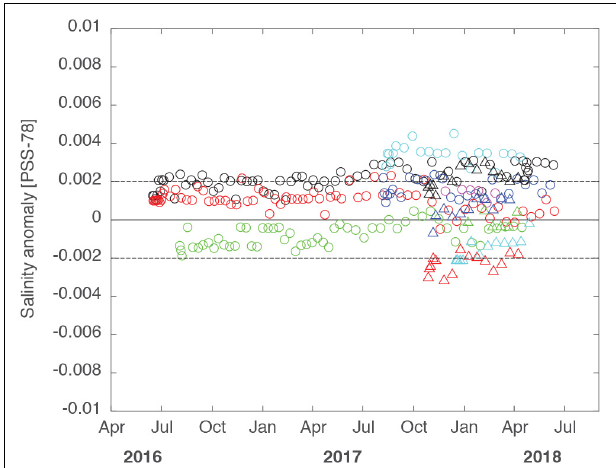
FIGURE 8 | Salinity difference between Deep SOLO SBE-61 CTDs and ship-based hydrographic data interpolated at Deep SOLO float location, projected on 0.74 ◦ C potential temperature surface. CTD measurements are for 11 Deep SOLO floats deployed in the Southwest Pacific Basin (WMO ID numbers 5902456, 5902457, 5902478, 5902528, 5902529, 5905161, 5905162, 5905163, 5905164, 5905234,